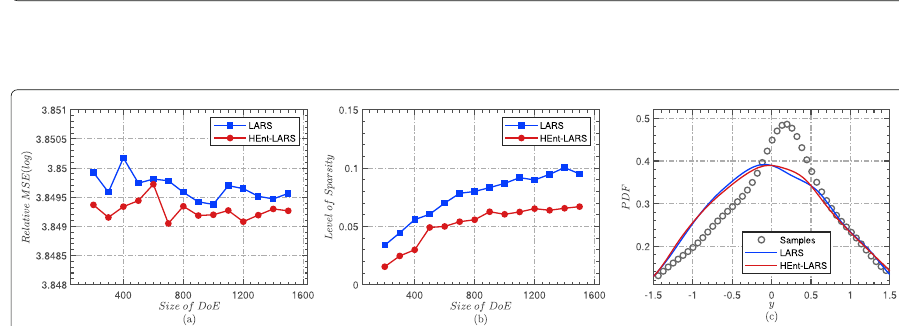
Fig. 11 Performance comparison of LARS, Ent-LARS and HEnt-LARS w.r.t. the high-dimensional function. ( a ) The relationship between the relative MSE and the size of DoE; ( b ) The relationship between the sparsity level of several methods and the size of DoE; ( c ) Enlarged details of the reconstructed PDF